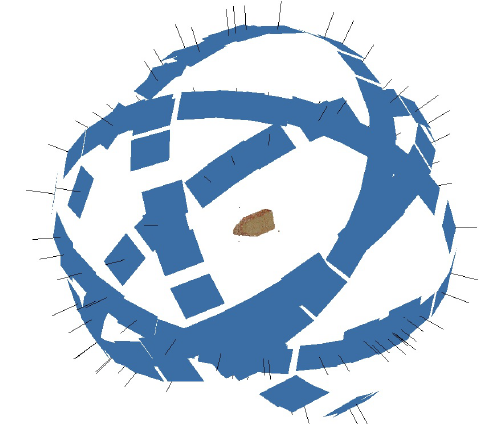
Figure 6. Photoscan image orientation of the fragment with Centauromachia scene.